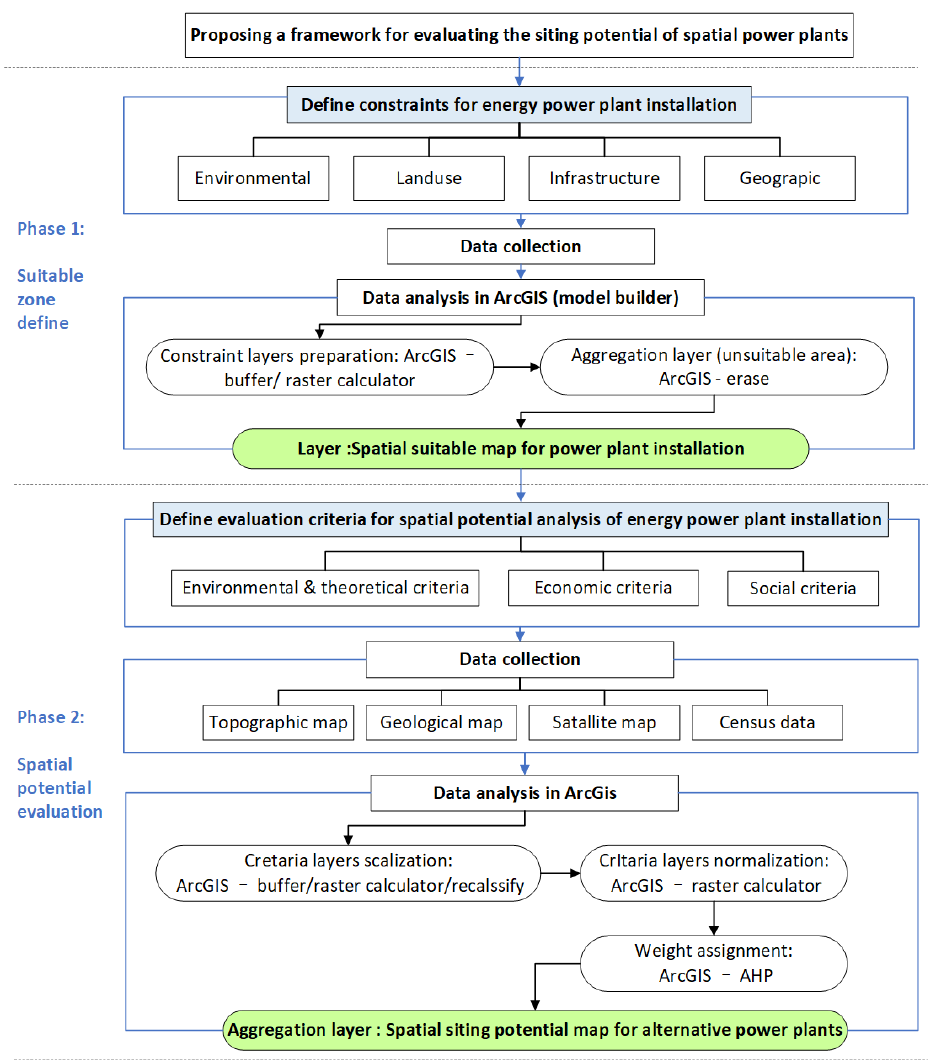
Figure 2. Flowchart of the methodology (adapted from Siefi et al. [44]).